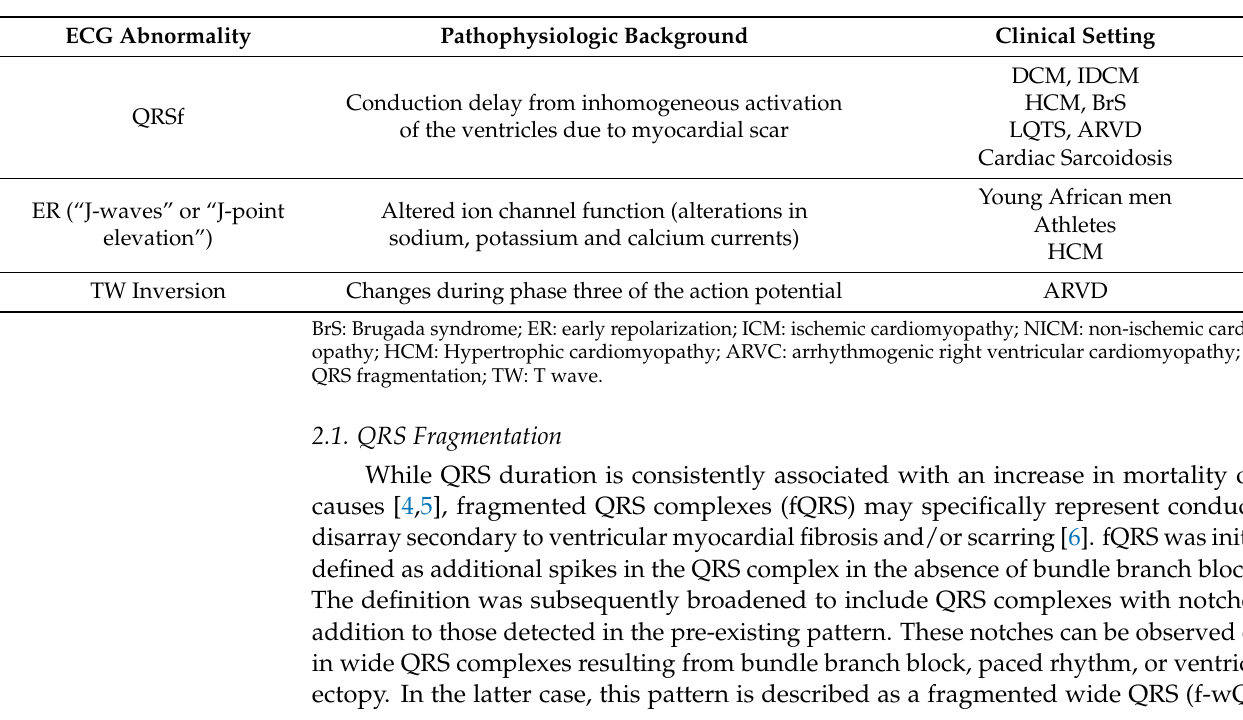
Table 1. ECG findings associated with an increased arrhythmic risk.